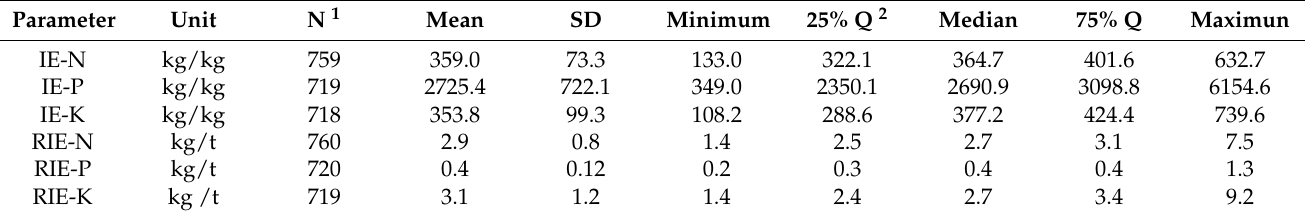
Table 4. Descriptive statistics of the internal efficiency (IE) of N, P and K (kilogram of fleshy fruit